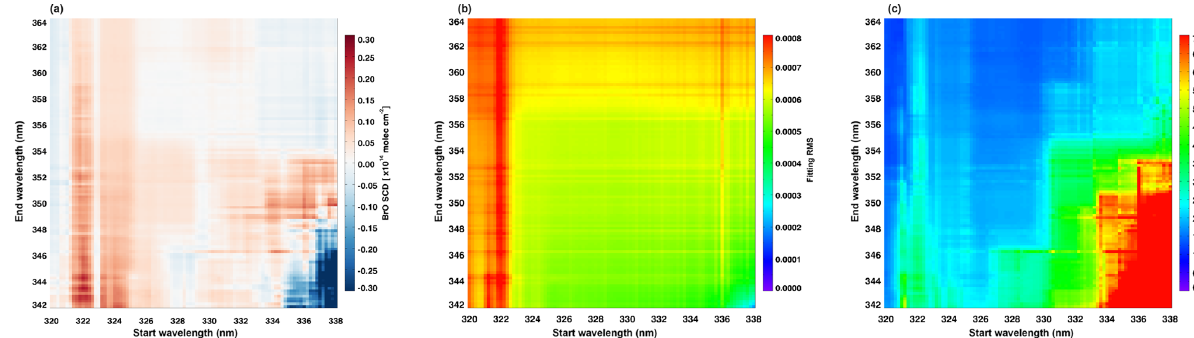
Figure 8. As Fig. 7 but for the cloudy part of the Pacific background region.